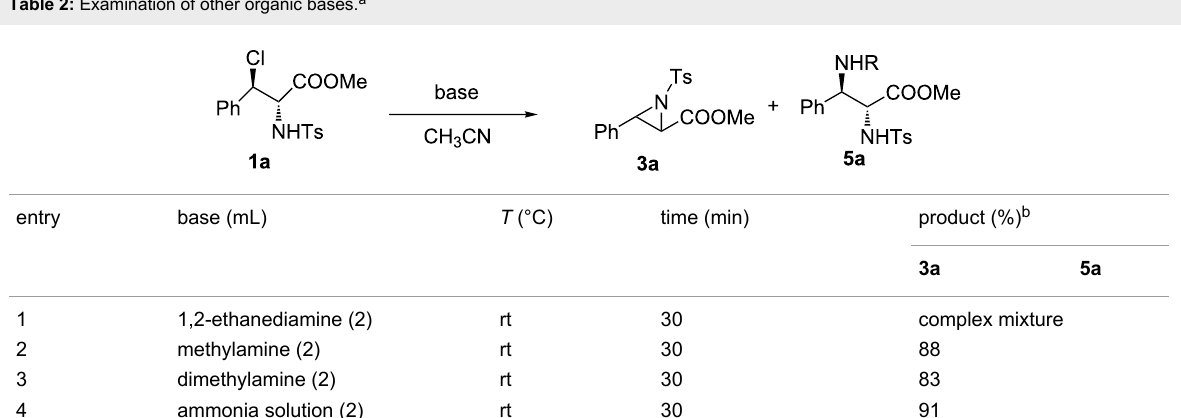
Table 2: Examination of other organic bases.